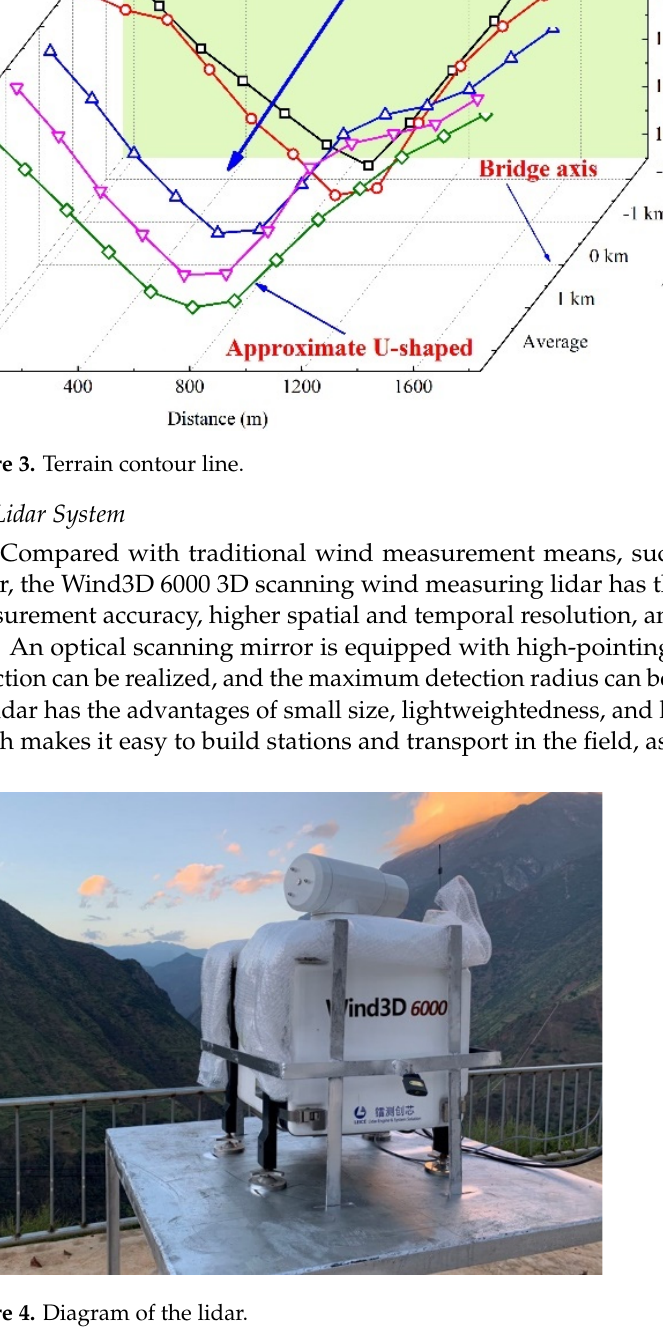
Figure 4. Diagram of the lidar.